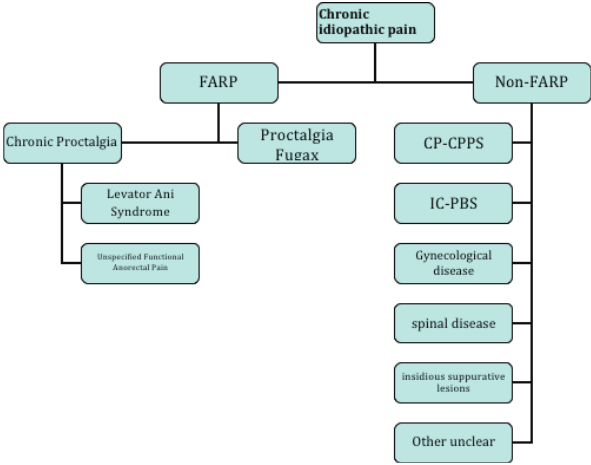
Figure 1: The classification of chronic idiopathic anal pain in